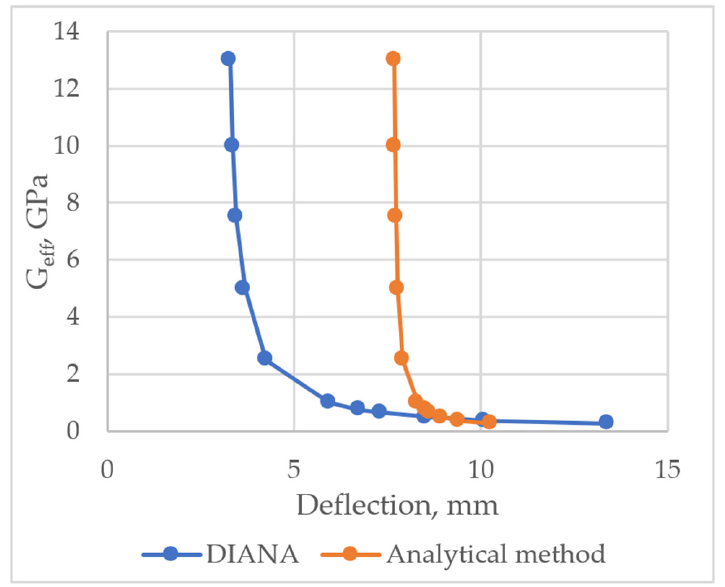
Figure 17. The relationship between the deflection of the prefabricated monolithic slab and the stiffness of the layer bond.